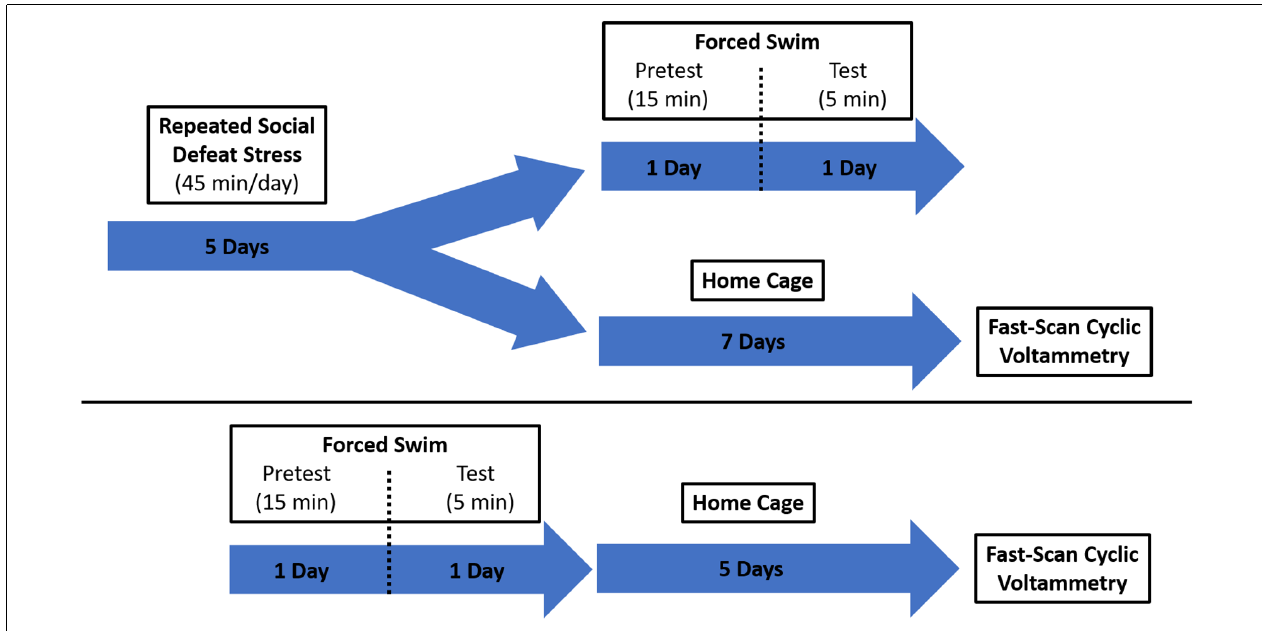
FIGURE 1 | Schematic showing the experimental design. Two groups of rats were exposed to different stress paradigms, social defeat and forced swim. They were then evaluated for protracted effects of stress on catecholamine dynamics using fast-scan cyclic voltammetry (FSCV).